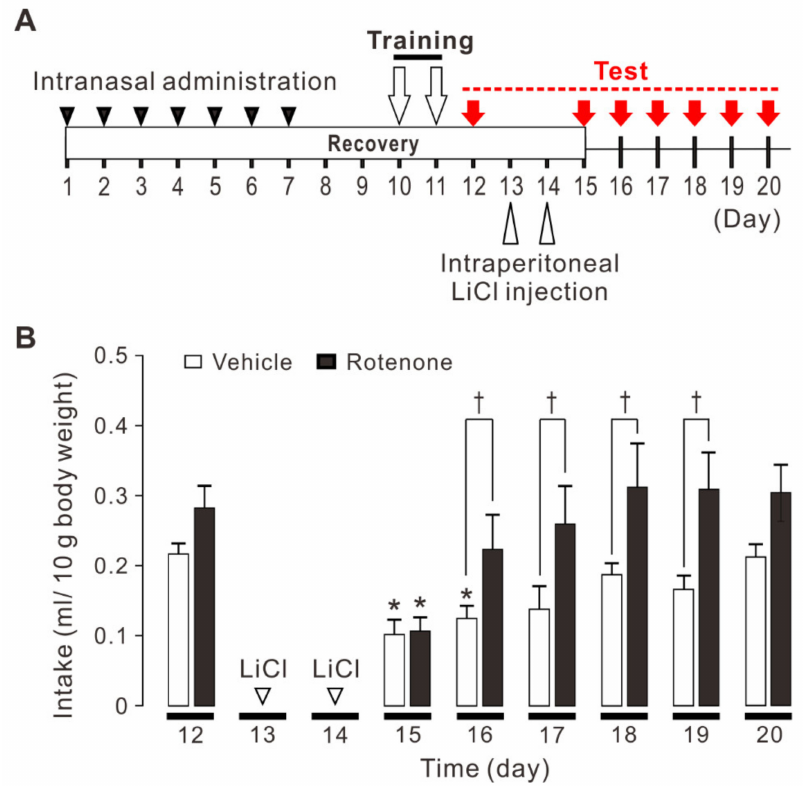
Figure 1. Conditioned taste aversion to quinine hydrochloride (QHCl) in vehicle (DMSO)-treated and rotenone-treated mice. ( A ) The experimental schedule in this study. After intranasal administration of rotenone for 7 days and recovery time for 3 days, water-deprived mice for 16 h were trained for two days to perform brief-access licking of distilled water through a single drinking bottle. On the next day, the mice were presented with 0.03 mM QHCl solution for 10 min and the amount consumed from a single drinking bottle was measured. Over the next two days, the paring of CS with US was repeated. The mice were presented with 0.03 mM QHCl solution as CS and given an intraperitoneal injection of 0.6 M LiCl (0.6 mg/kg body weight) as US. From the next day, the amount of 0.03 mM QHCl solution consumed for 10 min was measured for 6 days. ( B ) Both vehicle-treated mice ( n = 6) and rotenone-treated mice ( n = 6) showed conditioned taste aversion on the 15th day (1 day after paring of CS with US). On the 16th day (2 days after pairing of CS with US), conditioned taste aversion was extinguished rapidly in rotenone-treated mice, but not in vehicle-treated mice, returning to the control level. On the 16th, 17th, 18th, and 19th day (2, 3, 4, and 5 days after pairing of CS with US), the amount of intake was significantly greater in rotenone-treated mice than in vehicle-treated mice. Two-way ANOVA LSD: * p < 0.05 vs respective controls (intake on the 12th day); Two-way ANOVA LSD: † p <